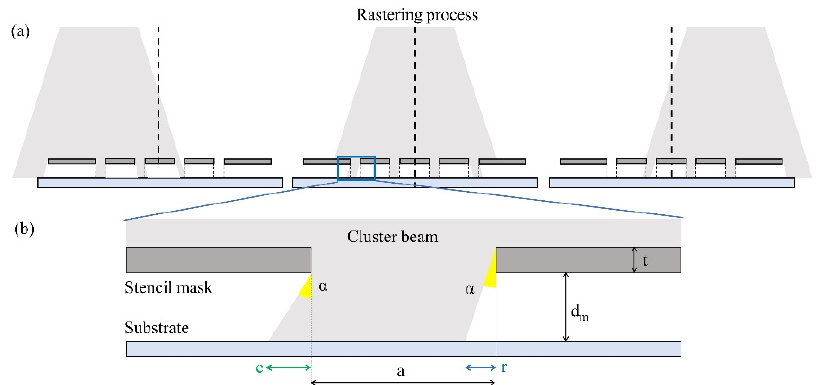
Figure 5. Schematic representation of a beam passing through a stencil mask and impinging on a substrate. ( a ) Rastering process: three different source–substrate relative positions are displayed, in which each opening intercepts a portion of the beam with a different inclination. ( b ) Single mask opening of extension a . A portion of the cluster beam passes through a stencil mask of thickness t with angle α and impinges on a substrate at a distance d m from the mask. Due to the non-zero inclination of the beam with respect to the normal to the substrate plane and the presence of a gap between the mask and the substrate, the beam overcomes the pattern borders, producing an enlargement e . Also, the right side of the pattern is not completely covered, causing a reduction of extension r in the deposition.